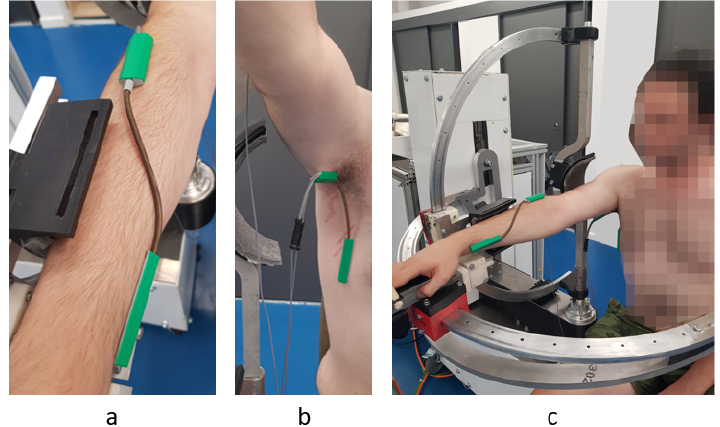
Figure 13. Goniometer used for measuring the pronation supination ( a ) Torsiometer used for measuring the pronation/supination of the forearm ( b ) Goniometer used for measuring adduction/abduction/flexion/extension for the shoulder; ( c ) the subject’s position during the in-lab experimental tests.